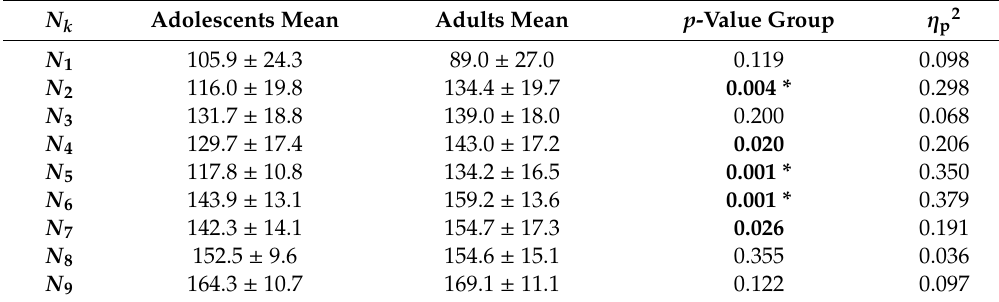
Table 4. N k of adolescents and adults in the di ff erent movement components. Results from eyes-open and eyes-closed conditions were pooled due to the absent eye condition e ff ect. Means ± SD of each group and corresponding p -values are presented. Bold values indicate p -values < 0.05; asterisks (*) mark significant di ff erences after Holm–Bonferroni correction. E ff ect sizes are displayed as η p2 (partial eta-square).